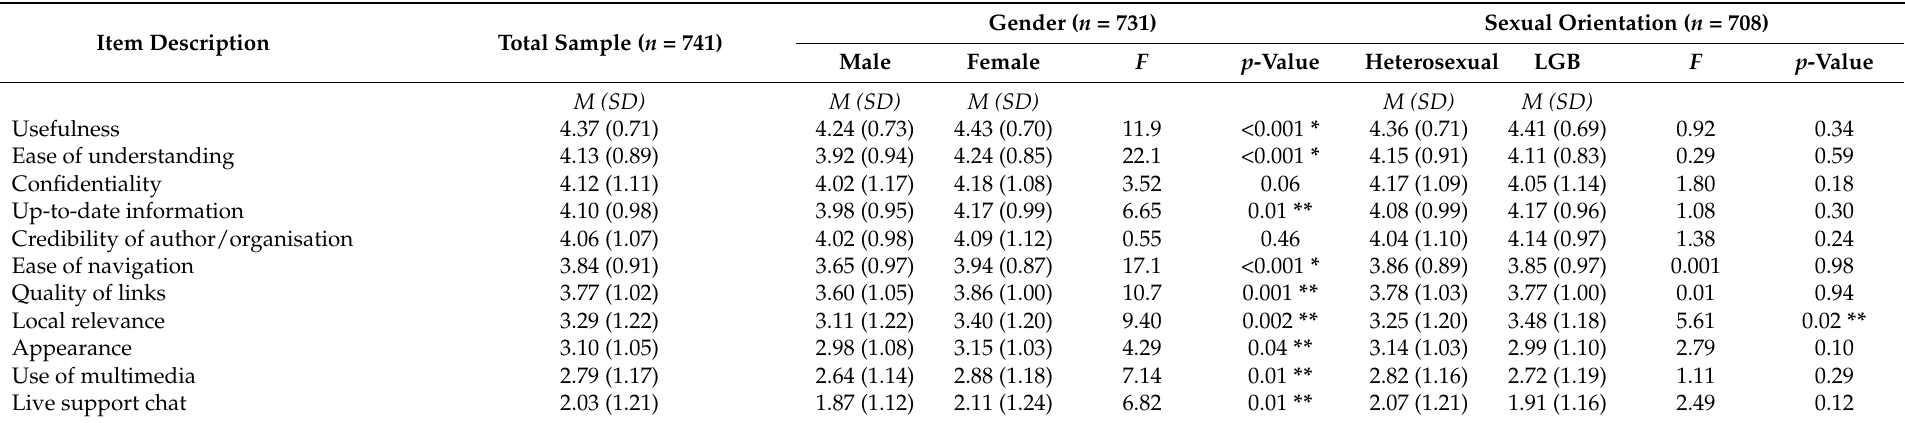
Table 4. Descriptive statistics for important factors when accessing sexual health websites, accounted for by gender and sexual orientation.